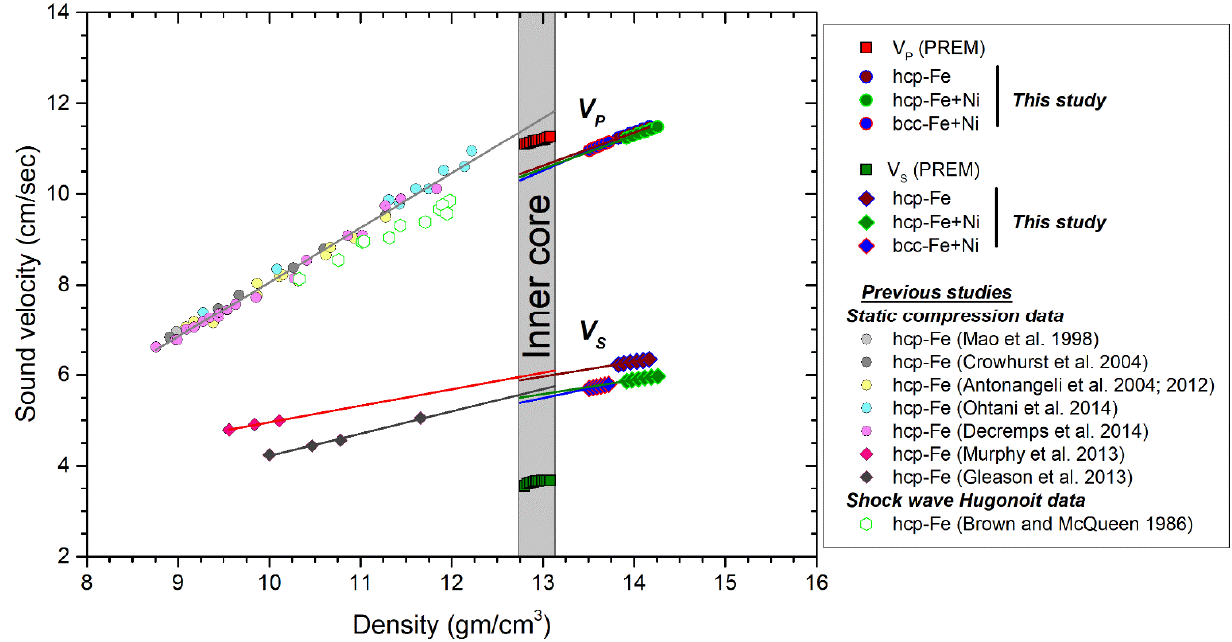
Figure 4. Calculated compressional and shear velocities of Ni-doped bcc and hcp Fe equivalents at inner core conditions as a function of density and compared with hcp-Fe and the experimental results from 300 K to 1000 K [33,34,56–61] and PREM [55] and shock wave Hugonoit measurements at high temperatures [62]. The computed densities of hcp-Fe-Ni alloy and hcp-Fe (filled green and brown circles and diamonds, respectively) are higher than PREM. However, the density of bcc-Fe-Ni alloy (filled blue circle and diamond) is close to PREM. Light grey circle: Mao et al. [56]; grey circle: Crowhurst et al. [59]; yellow circle: Antonangeli et al. [57,58]; cyan circle: Ohtani et al. [33]; magenta circle: Decremps et al. [61]; green hexagon: Brown and McQueen, [62]; red diamond: Murphy et al. [34]; grey diamond: Gleason et al. [60]. The solid lines are a linear regression across all previous experimental results and theoretical data from the present study.